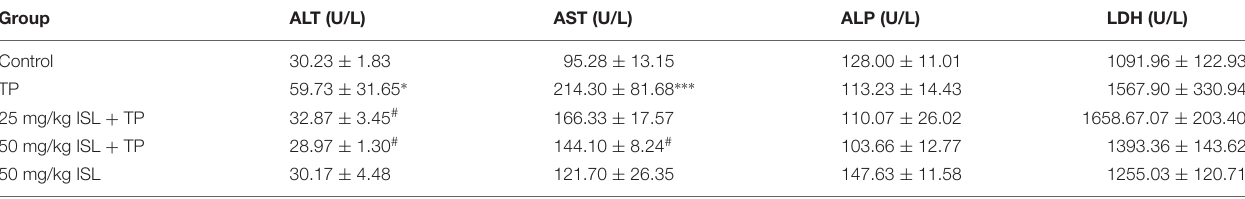
TABLE 2 | Blood chemistry of male ICR mice administered TP, ISL, or both (mean ± SD, n = 5–6). Group